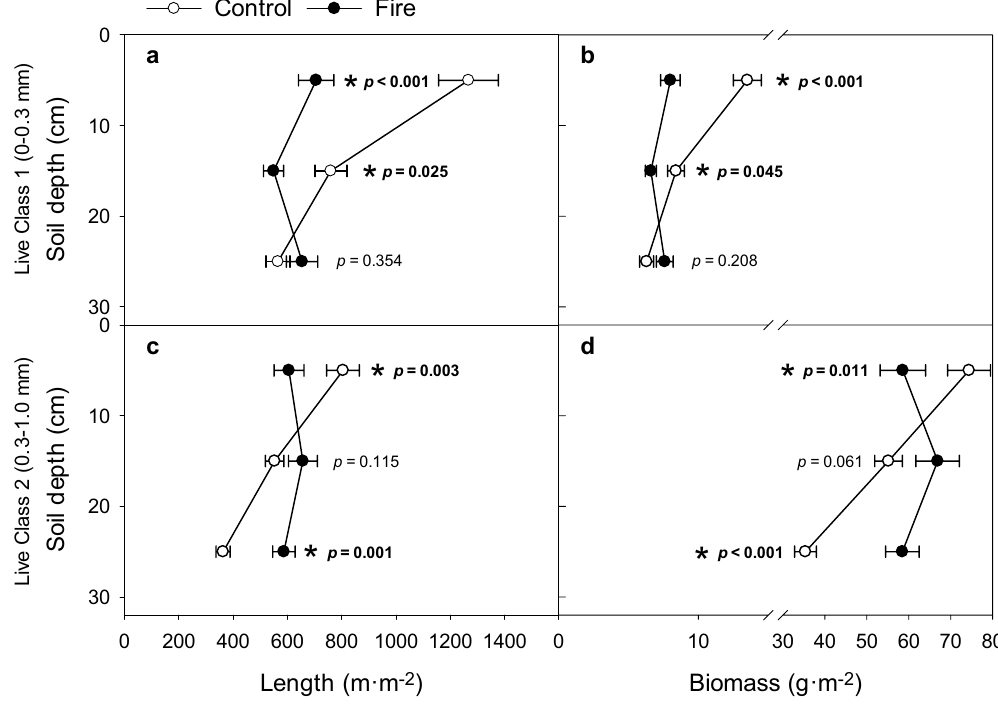
Figure 2. The significant interactions of fire × soil depth on live fine root length (m·m −2 ) and standing biomass (g·m −2 ) for Root Class 1 (0–0.3 mm) ( a) and ( b) respectively) and Root Class 2 (0.3–1.0 mm) ( c ) and ( d ) respectively). For control ( ○ ; n = 40) and fire-affected ( ● ; n = 30) trees, significant differences ( p < 0.05) determined by paired t-test and shown in bold with an asterisk.